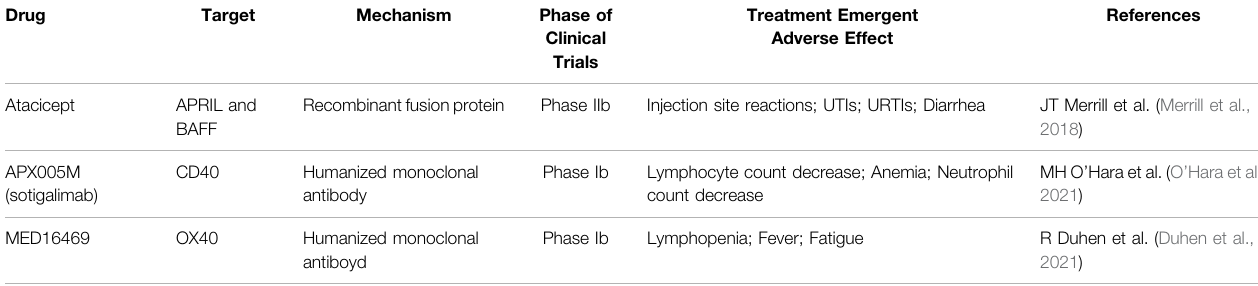
TABLE 1 | Summary of clinical trials targeting members of TNF(R)SF. UTI: urinary tract infection; URTI: upper respiratory tract infection.